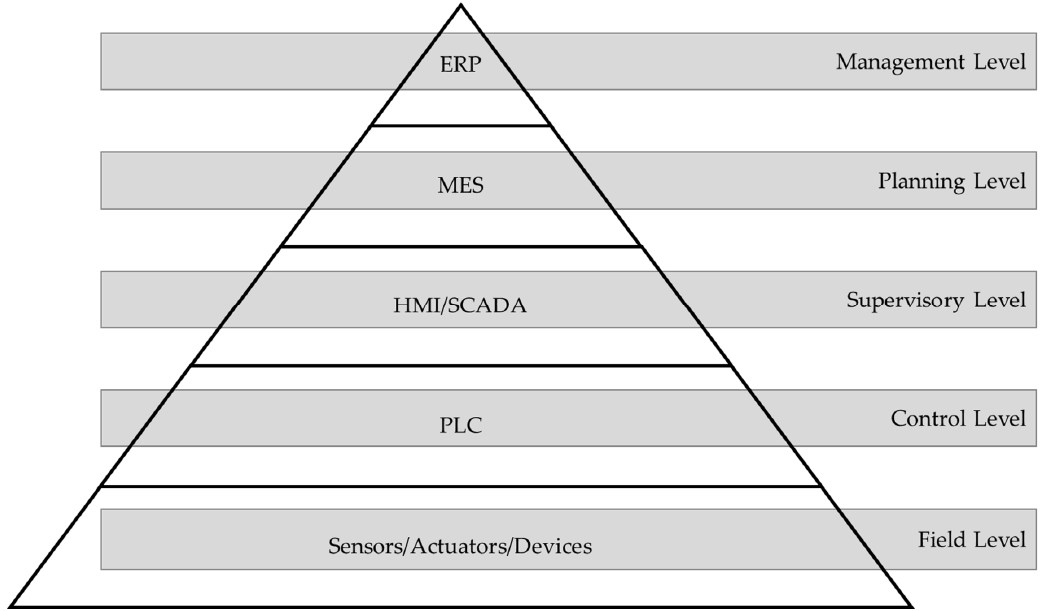
Figure 2. Hierarchical control pyramid (Adapted from References [15,19], own illustration).